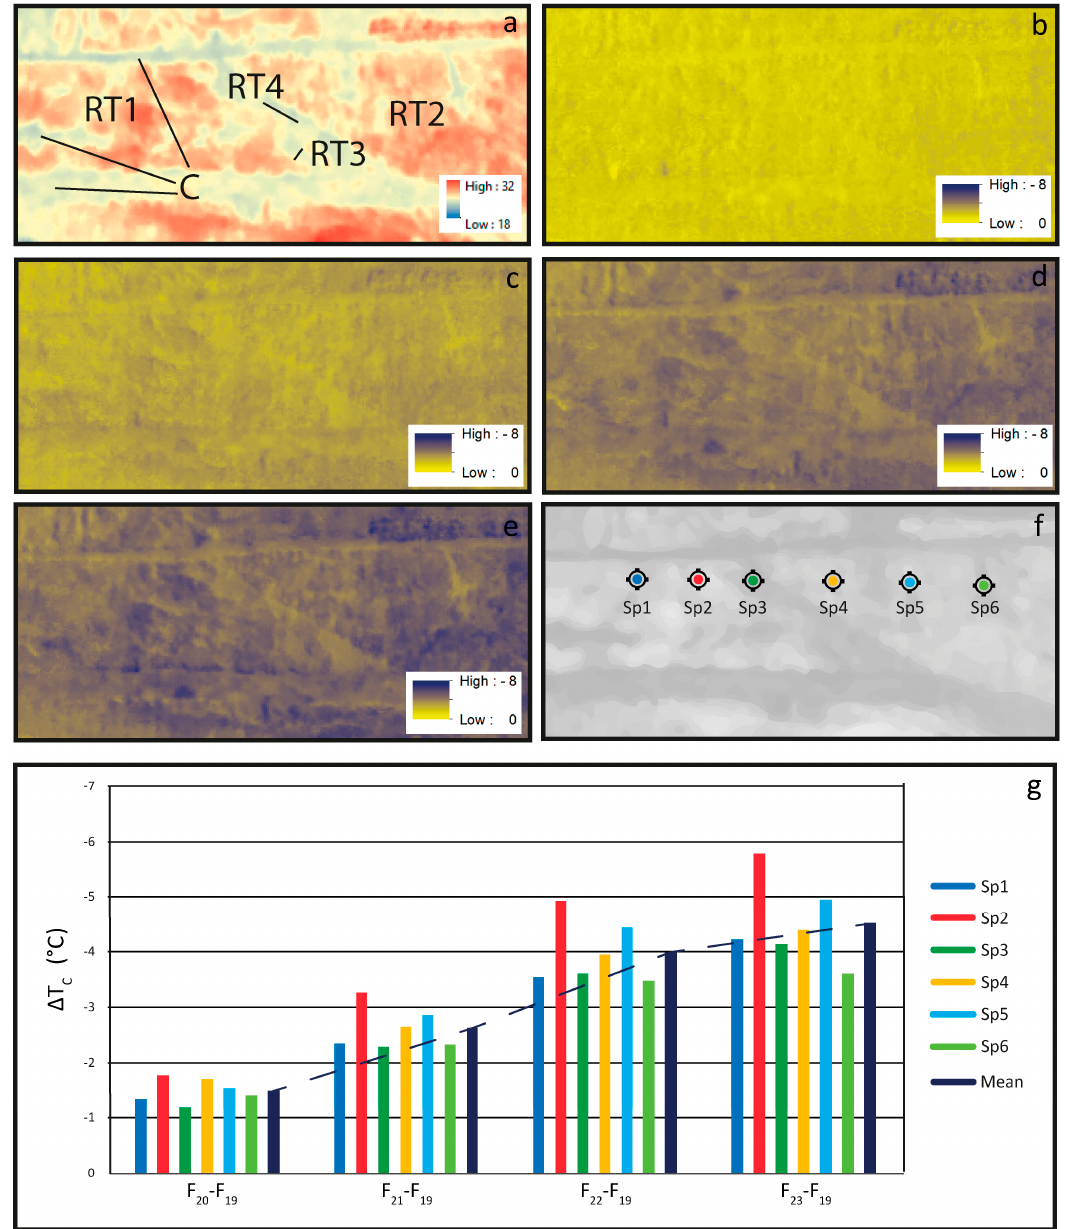
Figure 10. Summer measurement session ( a ) = image at 19:00 (F 19 ), ( b ) = F 20 -F 19 , ( c ) = F 21 -F 19 , ( d ) = F 22 -F 19 , ( e ) = F 23 -F 19 , ( f ) = position of measurement points, and ( g ) = temperature differentials of the spot measurement points.